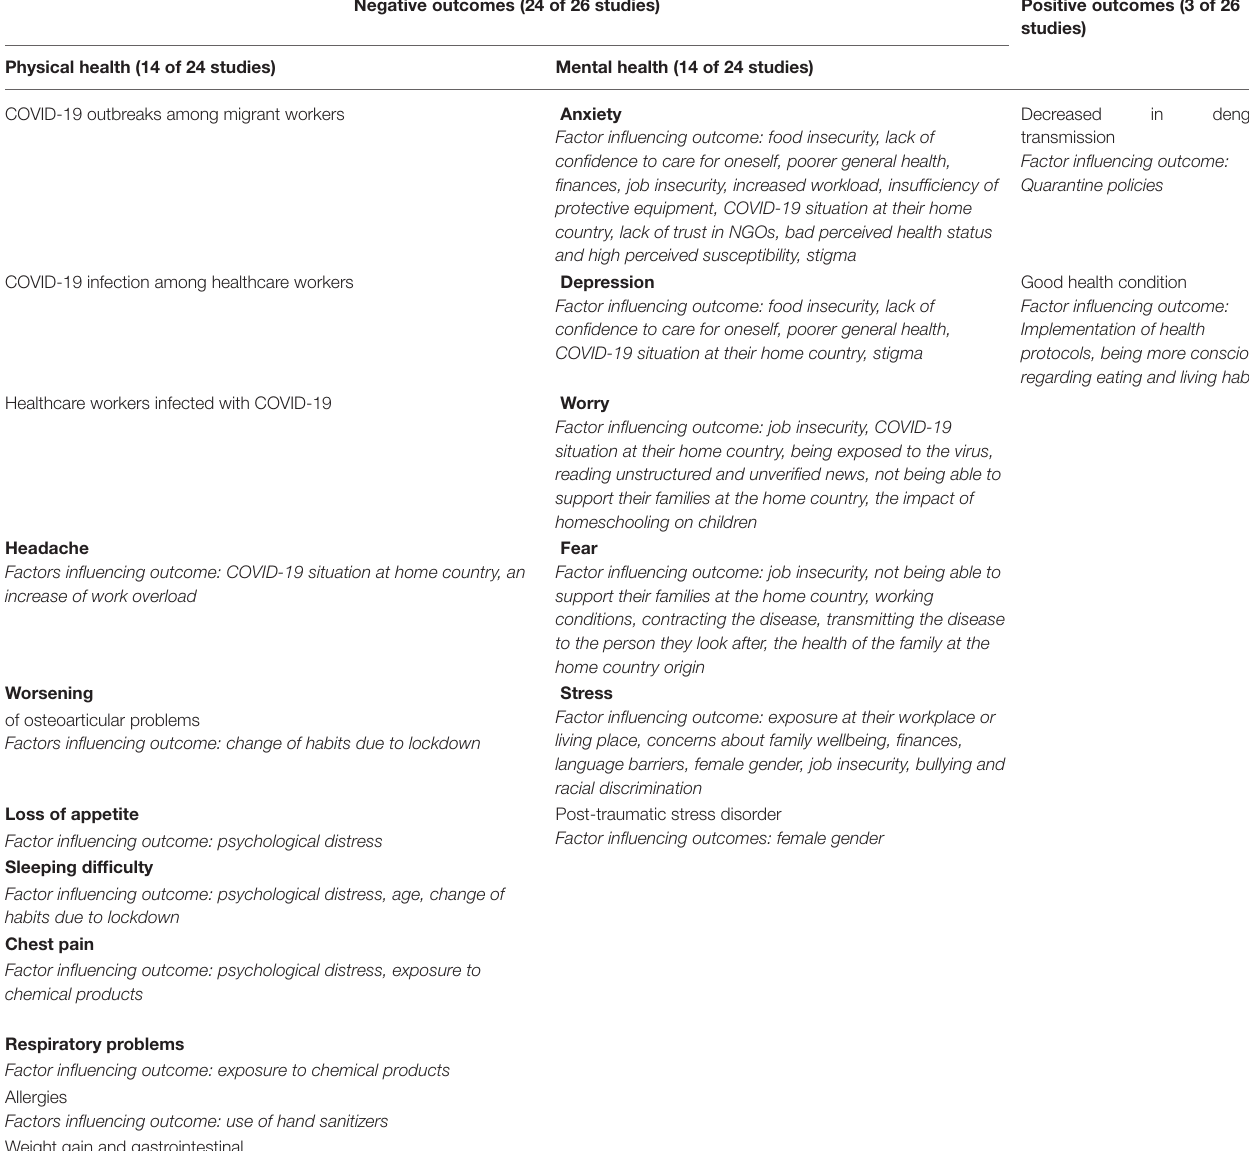
TABLE 3 | Classification of the articles by type of outcomes and their influenced factors. Negative outcomes (24 of 26